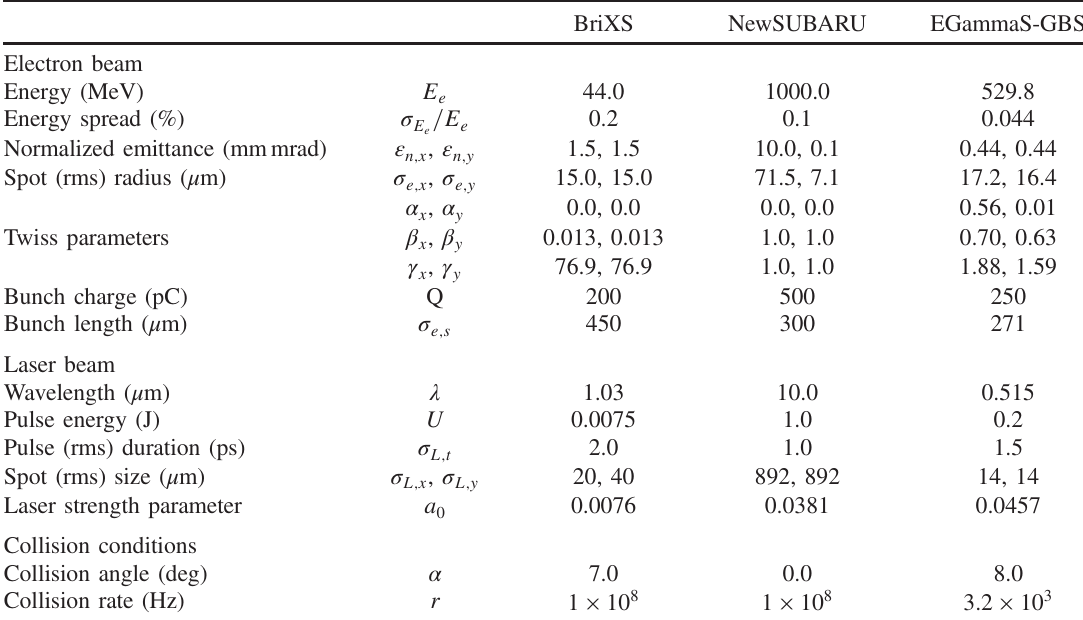
TABLE I. Features of the colliding beams for the three sources considered.